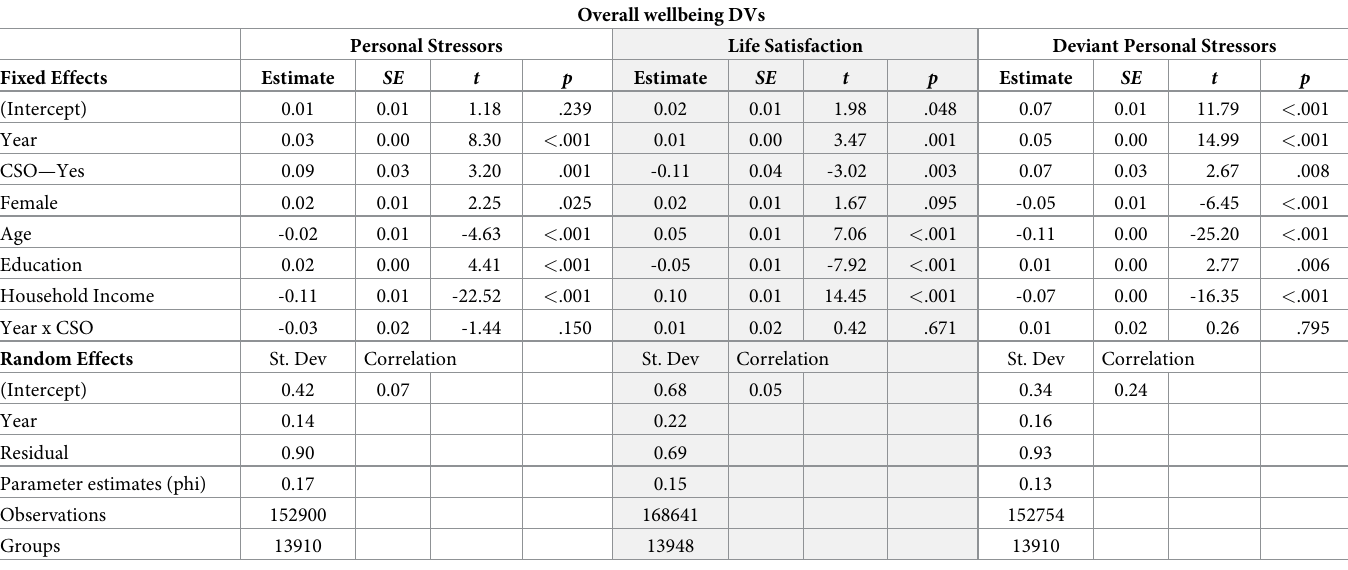
Table 2. Generalised linear mixed-effects model results for overall wellbeing variables.